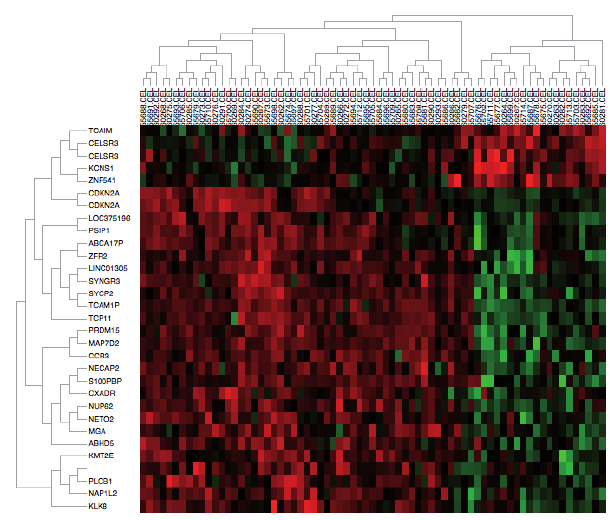
Figure 1. Heatmap displaying the relative expression of the probes with p values below 0.0001 from the example analysis, including CDKN2A. We note that sample names are truncated in the heatmap, but users can reduce the lengths of sample names or ensure that sample identity can be determined by the final characters in the name to associate specific samples with the